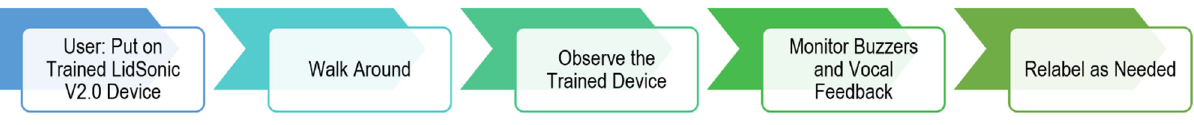
Figure 2. LidSonic: A User’s View.